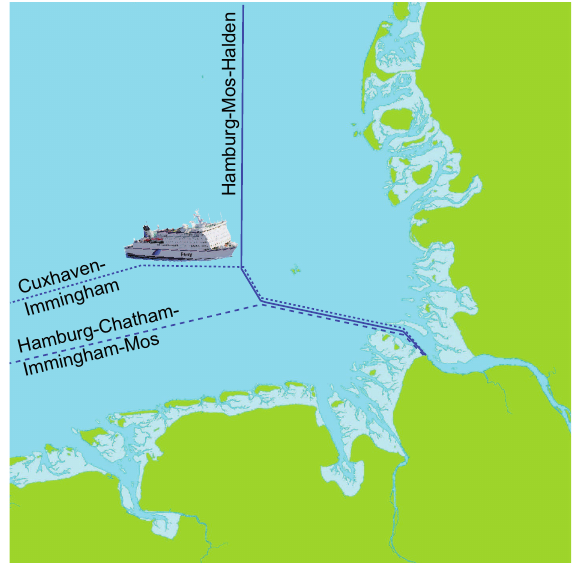
Fig. 3. FerryBox routes in the German